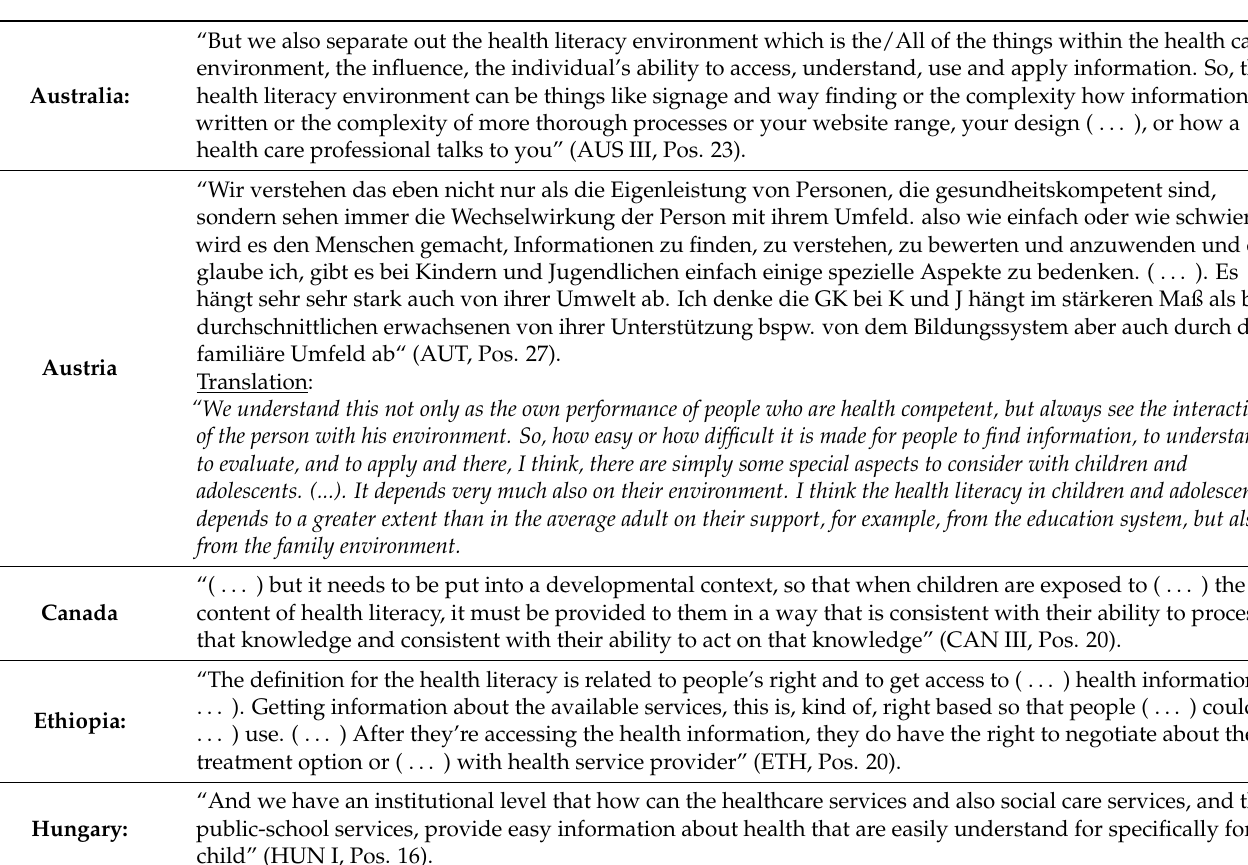
Table A3. Systems in responsibility: provision of and access to